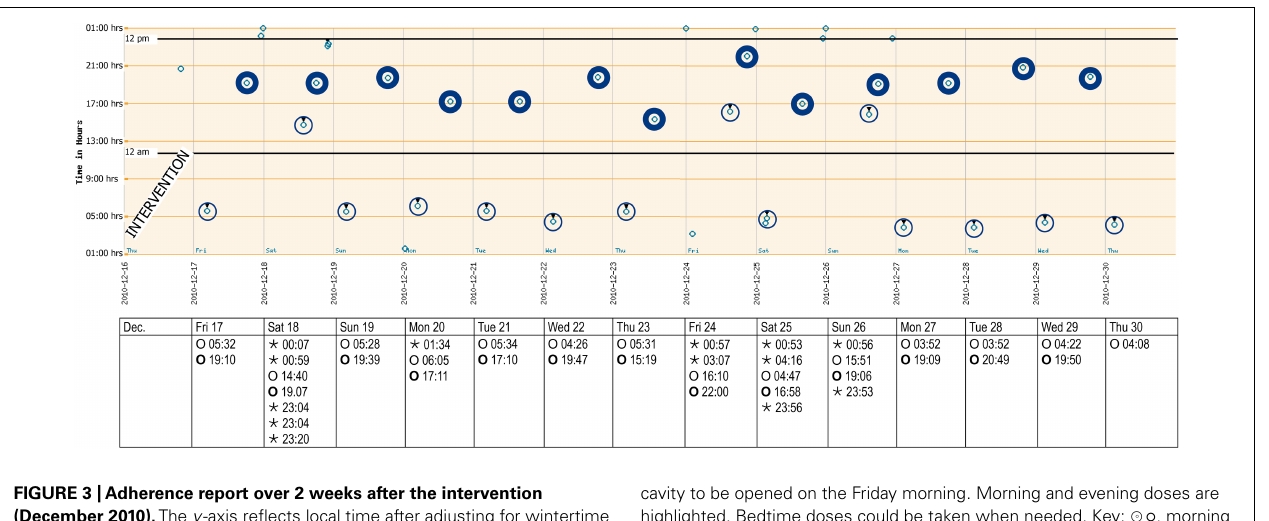
cavity to be opened on the Friday morning. Morning and evening doses are highlighted. Bedtime doses could be taken when needed. Key: ™ ◦ ◦ , morning doses; › ◦ › , evening doses; ◦ Õ , bedtime